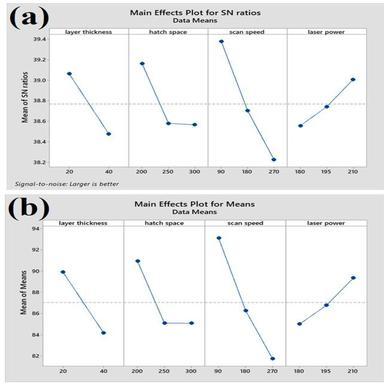
(a) The S/N ratio and (b) mean values for the effective parameters on the density measurements as determined by S/N and ANOVA analyses.